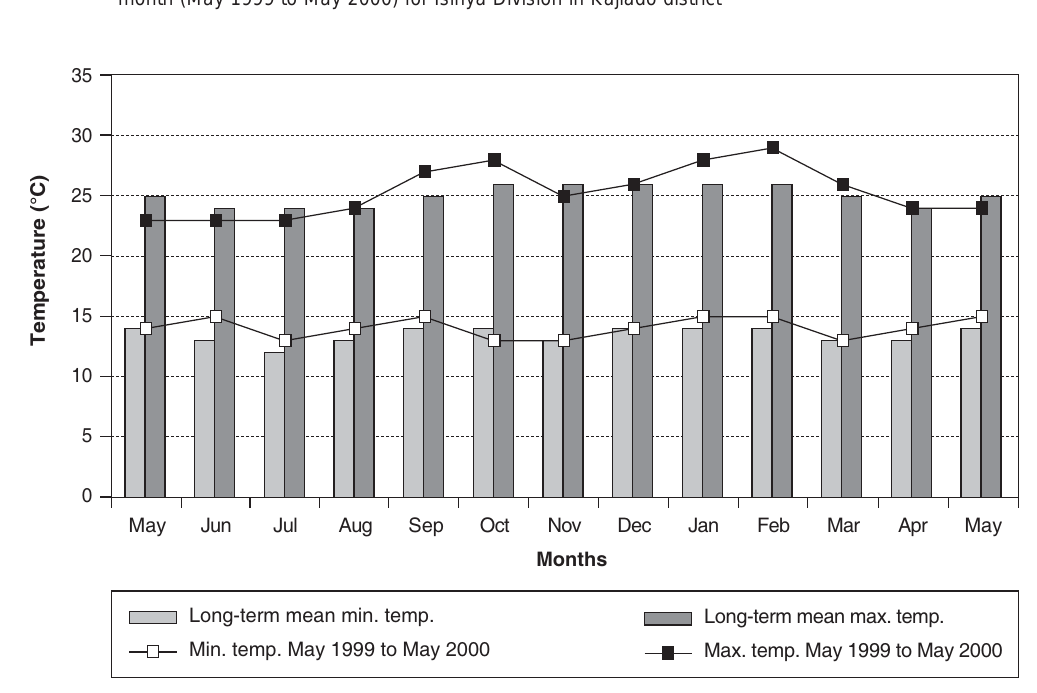
FIG. 2 Long-term mean minimum and maximum monthly temperatures (1969–1998) and the minimum and maximum monthly temperatures (May 1999 to May 2000) for Isinya Division in Kajiado